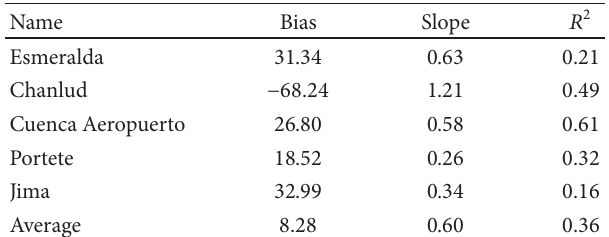
Table 5: Validation parameters for CFM. Multiyear monthly mean precipitation observed versus modeled with CFM. 𝑅 2 , bias and